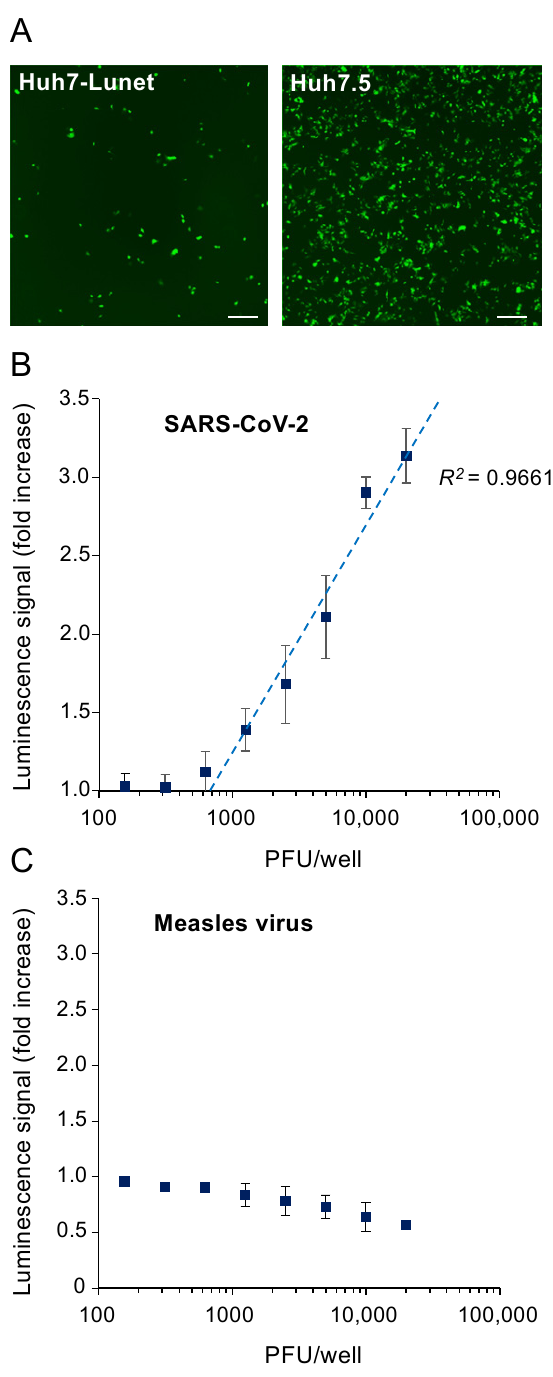
Figure 3. Activation of the luminescent biosensor by SARS-CoV-2 infection. ( A ) To compare their susceptibility to infection, Huh7-Lunet and Huh7.5 cells were infected with a recombinant strain of SARS-CoV-2 expressing mNeonGreen as a reporter (MOI = 0.5). After 20 h of culture, infection was determined by fluorescence microscopy and representative images are presented. Scale bar is 300 μ m. ( B ) In 96-well plates, Huh7.5 cells stably transfected with the 3CL Pro biosensor were infected with increasing amounts of SARS-CoV-2 (strain 2019-nCoV/USA_WA1/2020) ranging from 156 to 20,000 PFUs/well (i.e., 0.004 to 0.5 MOIs). After 24 h of culture, luciferase activity was determined. Data correspond to means ± SEM from 3 independent experiments in triplicate ( n = 1) or in duplicate ( n = 2). Linear regression was determined for PFUs/well ranging from 625 to 20,000 (i.e., 0.0156 to 0.5 MOIs) where some luciferase signal was detected. ( C ) Same experiment as in ( B ) but cells were infected with measles virus. Data correspond to means ± SEM from six experiments.